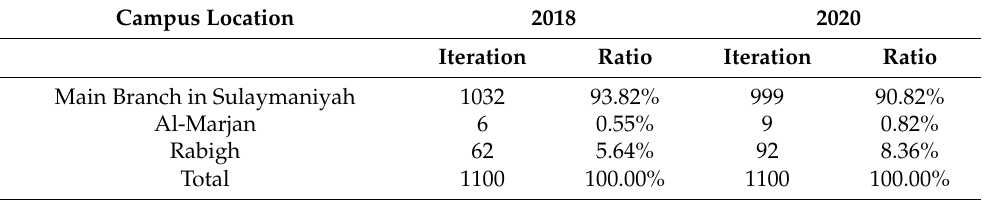
Table 3. Distribution of student numbers by campus location between 2018 and 2020 survey periods.